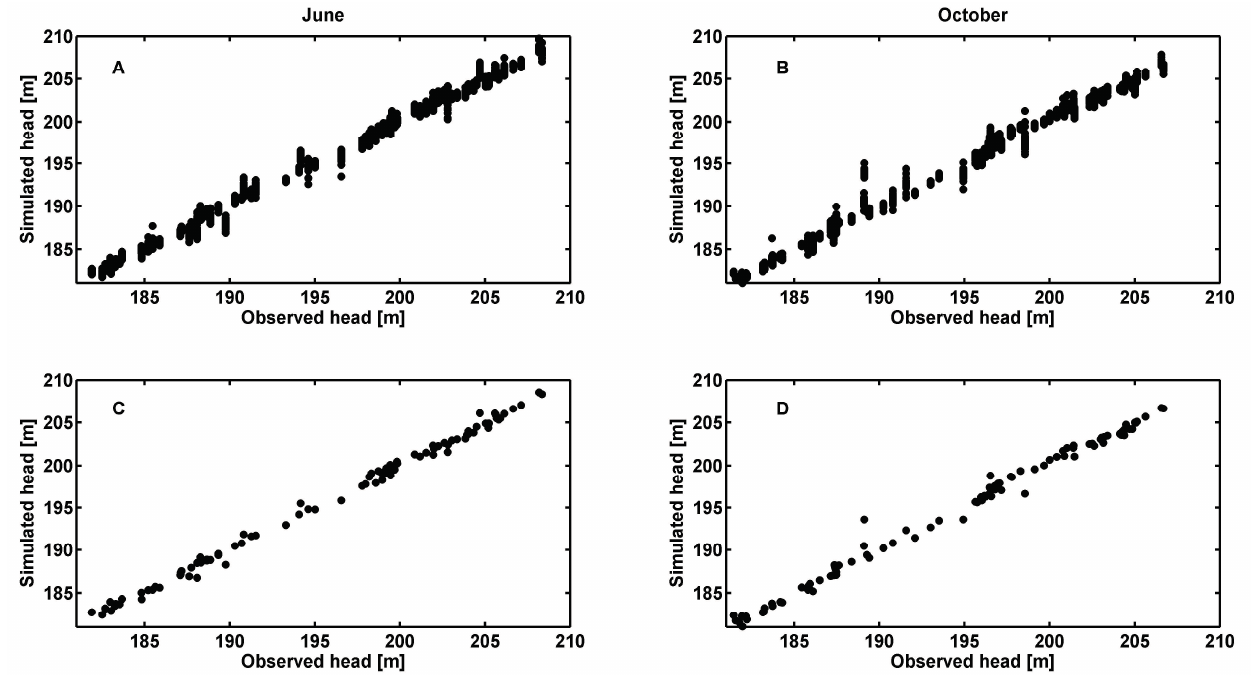
Figure 6. Simulated versus observed hydraulic heads for the CASE 1 and CASE 2 considering all Monte Carlo realizations (( A ) and ( B ), respectively) and considering only the realization with the best fitness ( i.e ., the smallest L (Equation (13))) (( C ) and ( D ),